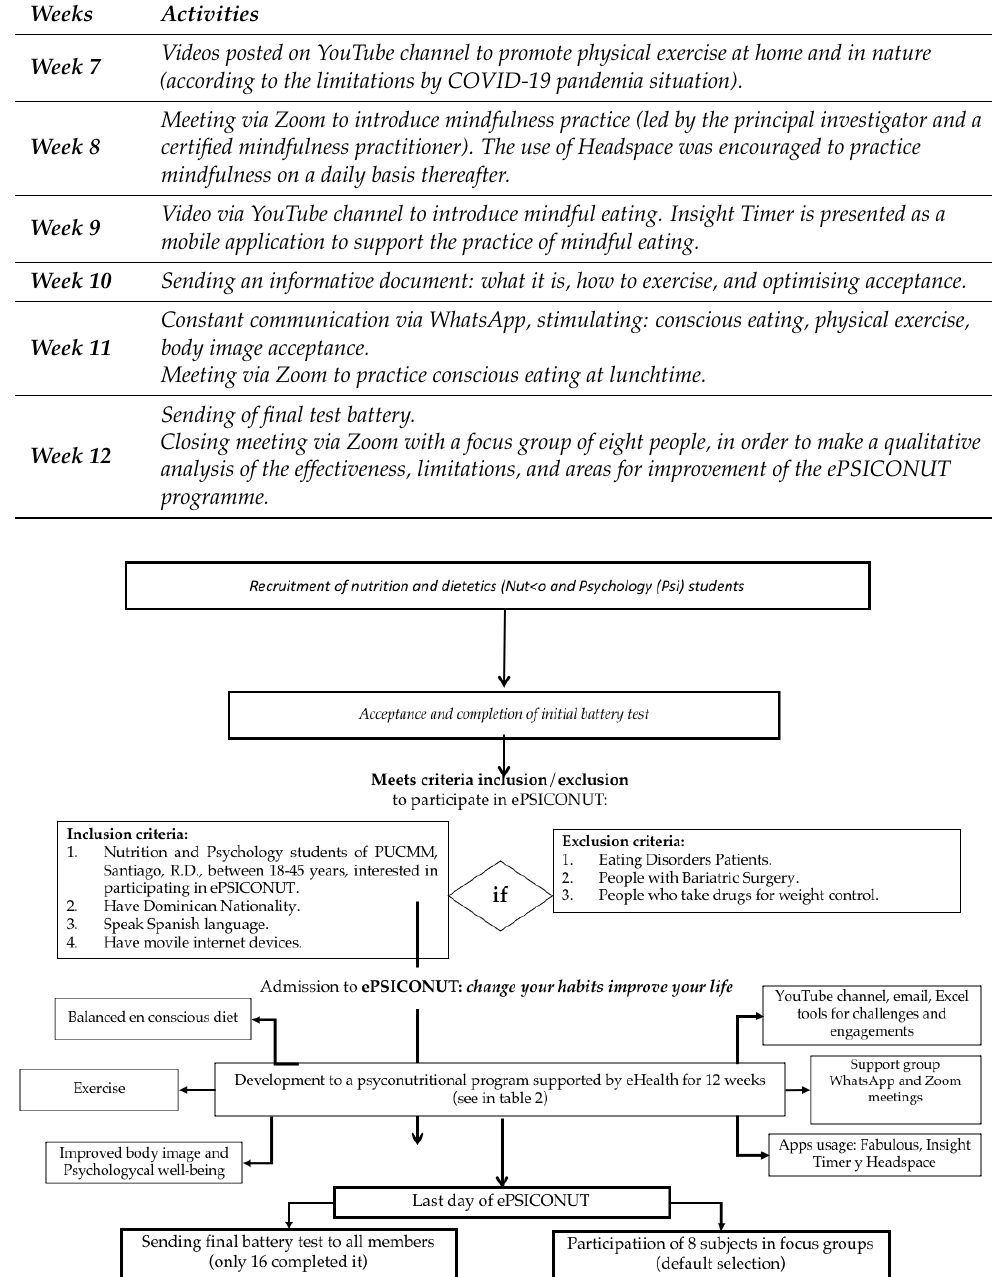
Figure 2. Diagram to summarise the experimental protocol of